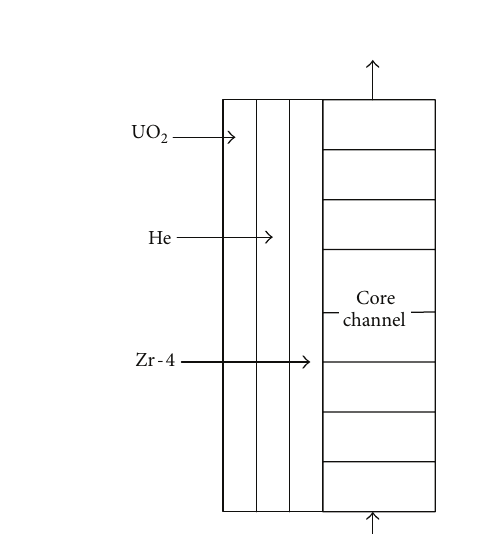
Figure 4: Node map of CIPWR.